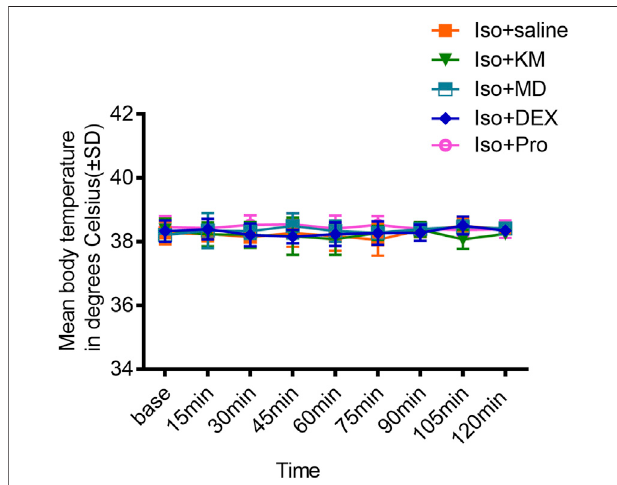
FIGURE 7 | The co-administration anesthetics or adjuvantdrugs did not change the body temperature. Comparisons with the saline co-administration group revealed that the core body temperature is not affected by ketamine, midazolam, dexmedetomidine, or propofol co-administration with 1.0% iso fl urane anesthesia. (two-way ANOVA: p (cid:1)